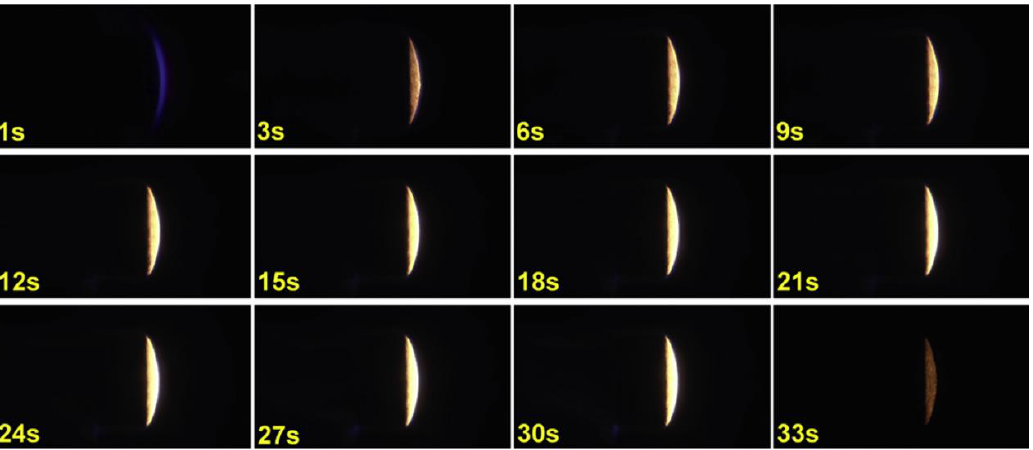
Figure 18. Screenshot of sample NCF-PR1/4 during the ablation test in an arc-jet wind tunnel recorded by camera from 1 to 33 s (Reprinted with permission from Ref. [90]. 2017 Elsevier).